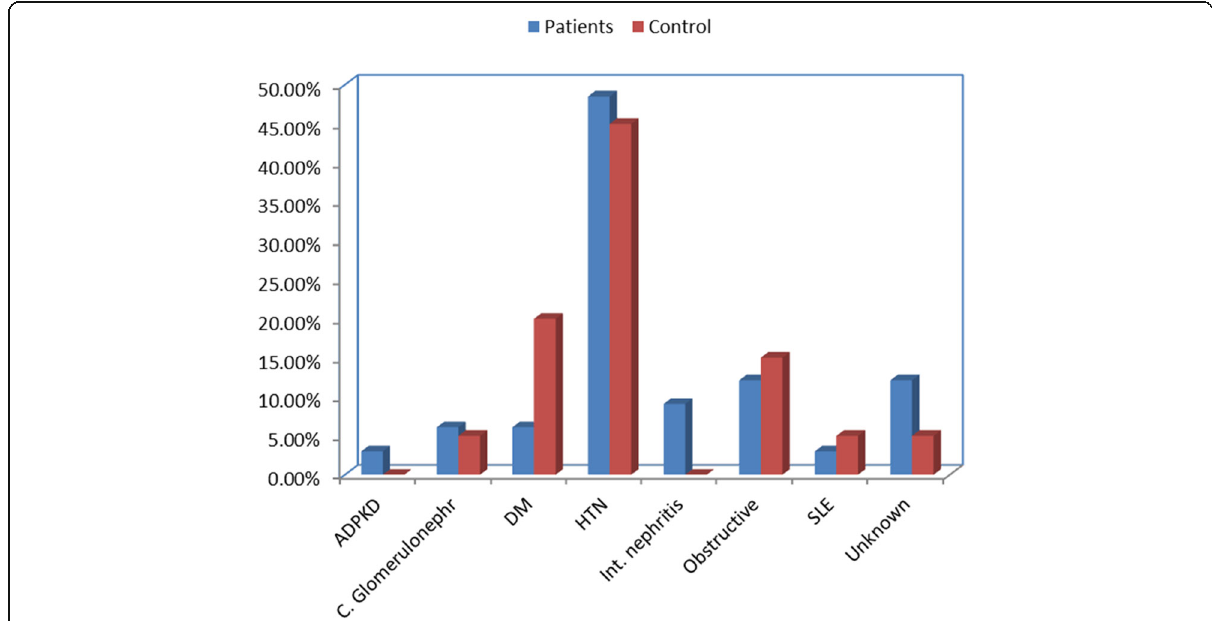
Fig. 1 Bar chart showing a comparison between the drug and control groups according to the etiology of renal